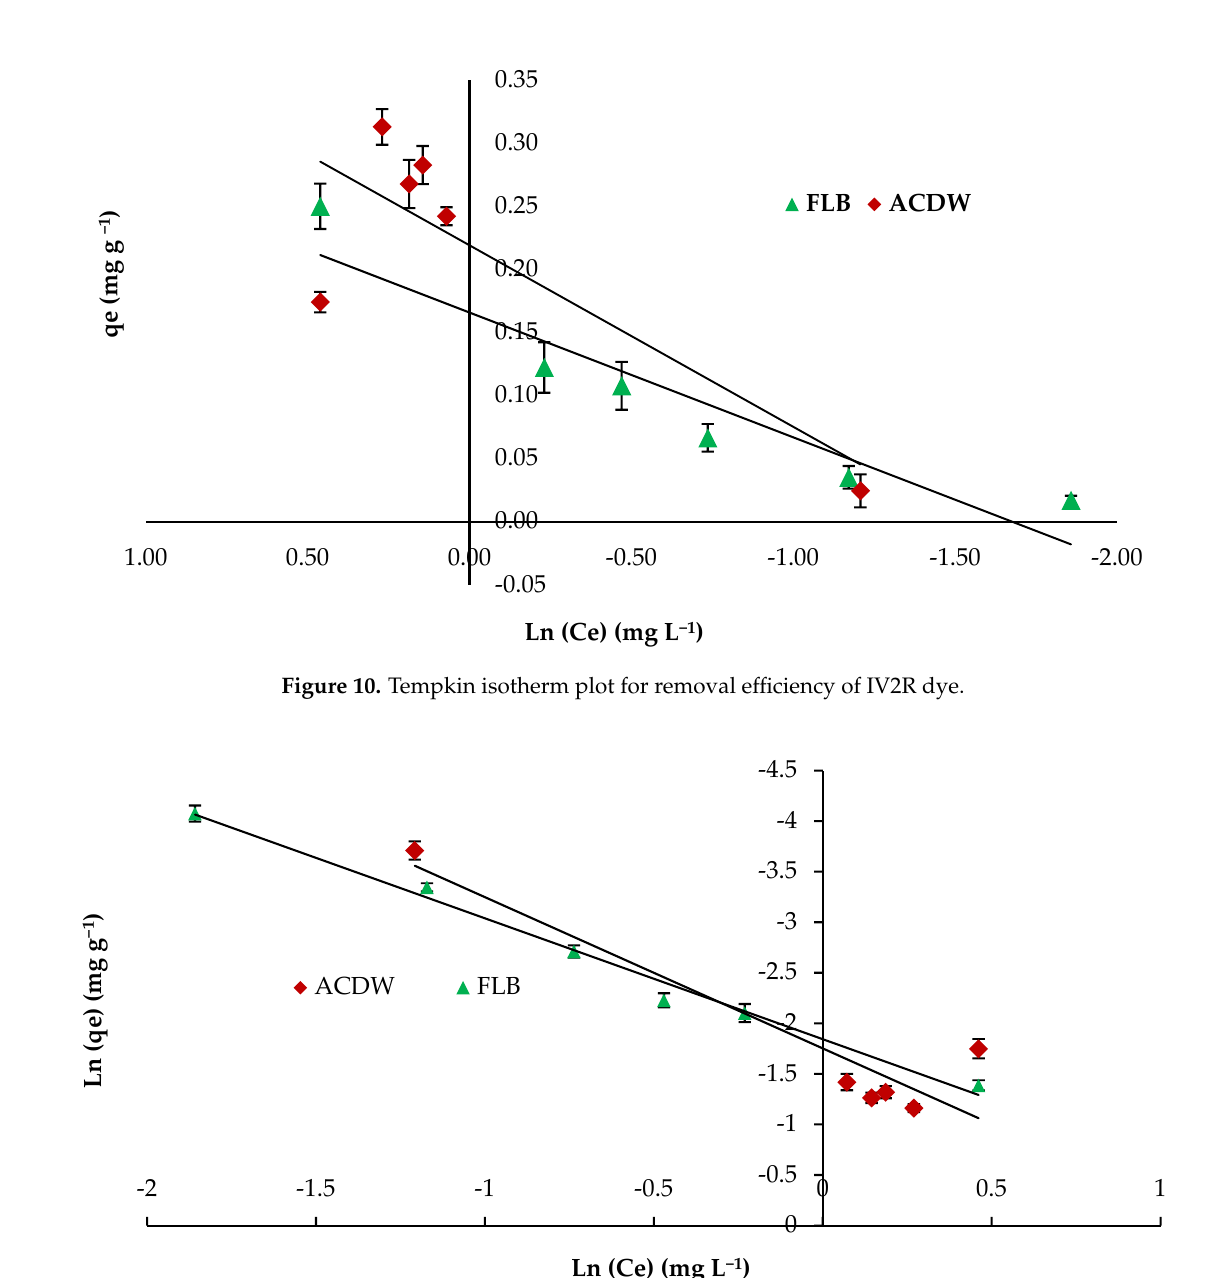
Figure 11. Halsey model plot for removal efficiency of IV2R dye.